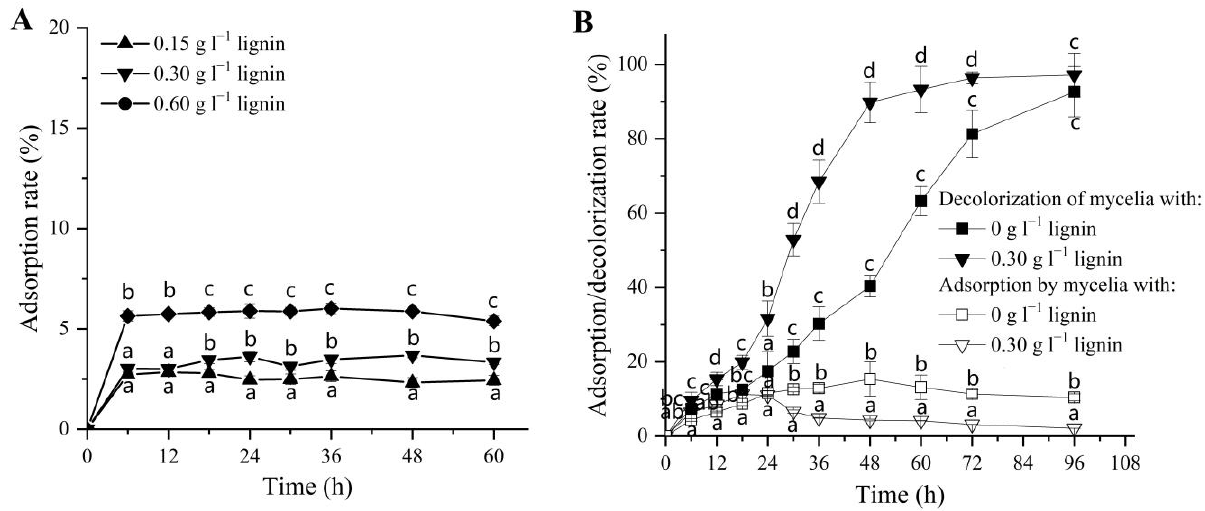
Figure 2. Physical adsorption of DR5B by alkali lignin and fungal mycelia. ( A ) Physical adsorption rate of DR5B when it was incubated with alkali lignin at contents of 0.15, 0.30, and 0.60 g L − 1 . ( B ) Physical adsorption rate of DR5B by G. lucidum EN2 mycelia in the presence of 0 and 0.30 g L − 1 alkali lignin. Decolorization by G. lucidum EN2 mycelia of DR5B in the presence of 0 and 0.30 g L − 1 alkali lignin. The vertical line on each bar indicates the standard deviation for three replicates (SD, n = 3). Different letters represent significant differences between treatment groups at each time point, as determined with two-way ANOVA followed by LSD or Tukey multiple comparison tests ( p <